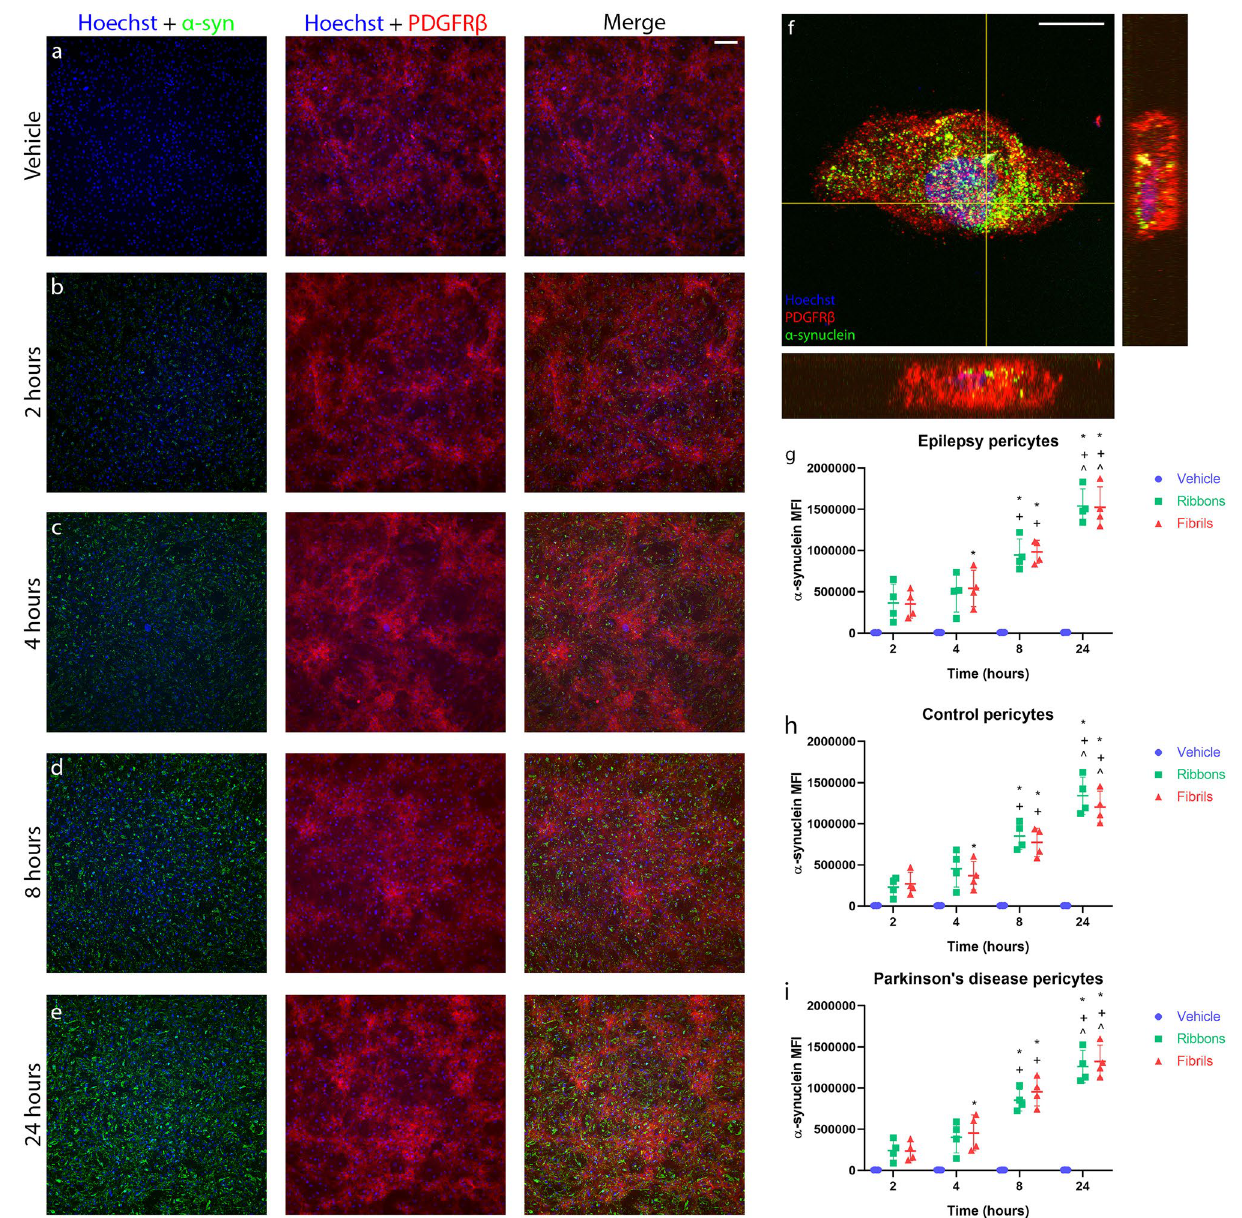
Figure 4. Uptake of α-syn in primary human brain pericytes. Pericytes were incubated with α-syn fibrils (100 nM) for 24 h. Pericytes did not contain endogenous α-syn ( a ), however, pericytes efficiently take up α-syn at ( b ) 2 h, ( c ) 4 h and ( d ) 8 h and ( e ) 24 h. ( F ) Orthogonal confocal microscopy reveals that α-syn is present within pericytes in vitro. Scale bar, 100 µm ( a–e ), Scale bar 10 µm ( f ). α-syn MFI was measured using fixed-flow cytometry in ( g ) epilepsy pericytes. ( h ) control pericytes and ( i ) PD pericytes after incubation with ribbons (100 nM) or fibrils (100 nM) for 24 h. ( n = 4 in each group, mean ± SD). * p < 0.05 compared to 2 h treatment, ^ p < 0.05 compared to 4 h treatment, ^ p < 0.05 compared to 8 h treatment; two way ANOVA with Tukey’s multiple comparisons